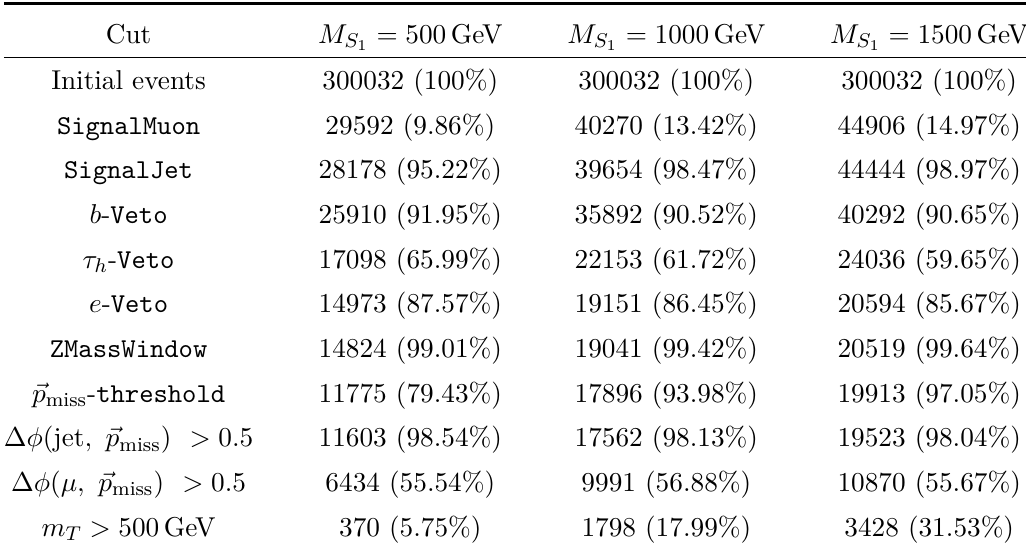
= 500 , 1000 and 1500 GeV. The numbers 1 = 100 GeV and ∆ X = 0 . 1 0